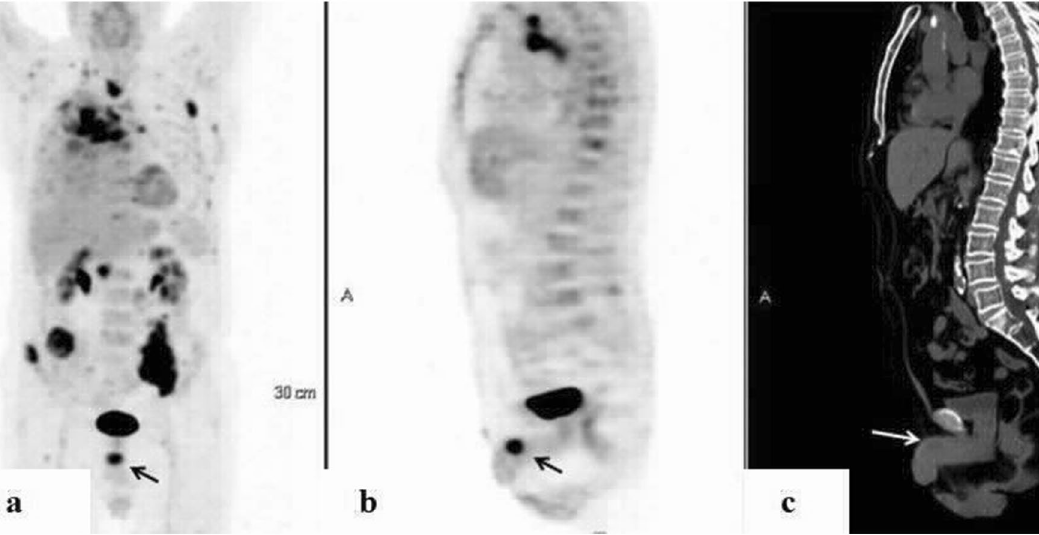
Figure 4. 18-FDG PET/CT: maximum intensity projection (MIP) ( a ) representative PET ( b ) and CT ( c ) axial slices demonstrating focally increased uptake in the penis. A 79-year-old man with metastatic non-small cell lung carcinoma and a prior history of prostate cancer who had undergone prior transurethral resection of the prostate (patient #21, Table 1).